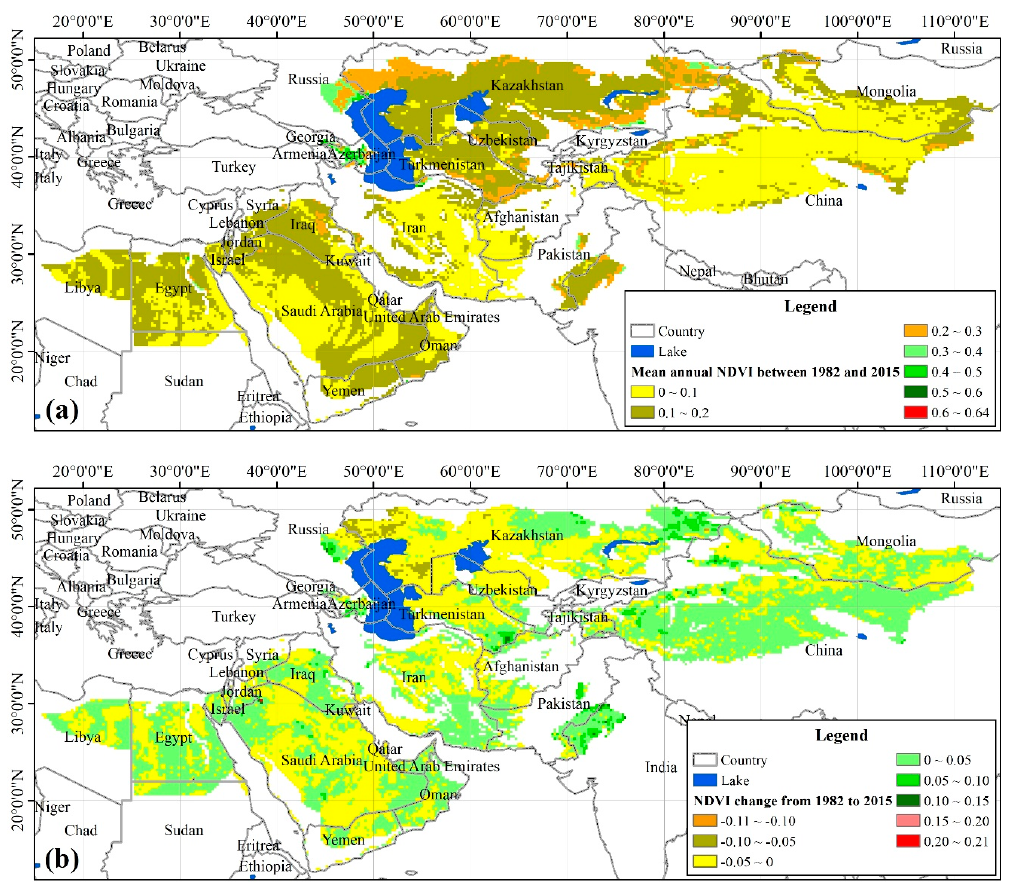
Figure 2. Mean annual NDVI (normalized difference vegetation index , ( a ) and its change range (NDVI 2015 –NDVI 1982 , ( b ) in desert areas over the Silk Road Economic Belt between 1982 and 2015.